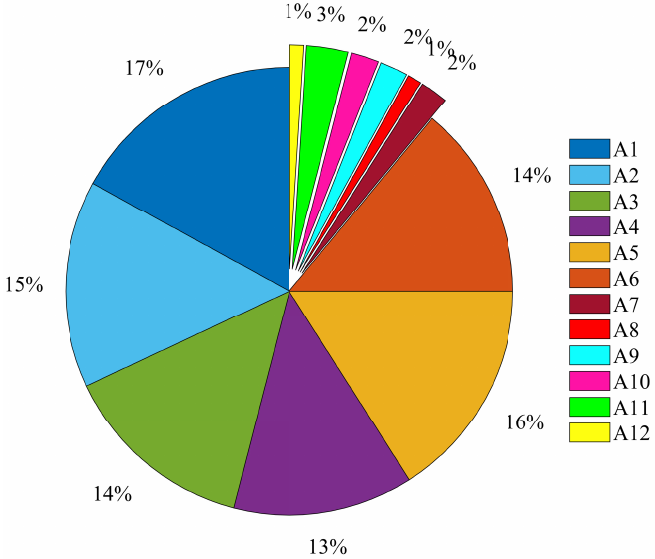
Figure 2. Percentage of different action categories in